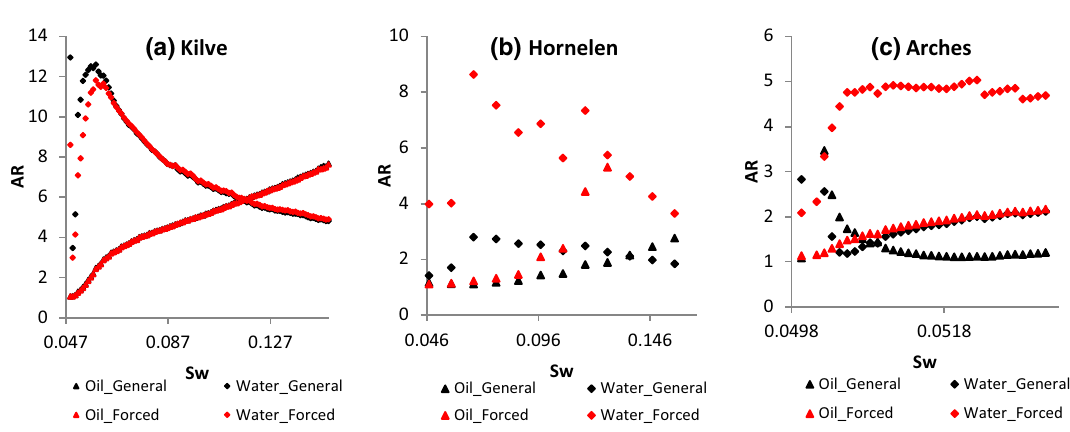
Fig. 7 Anisotropy ratio for Kilve ( a ), Hornelen ( b ), and Arches ( c )